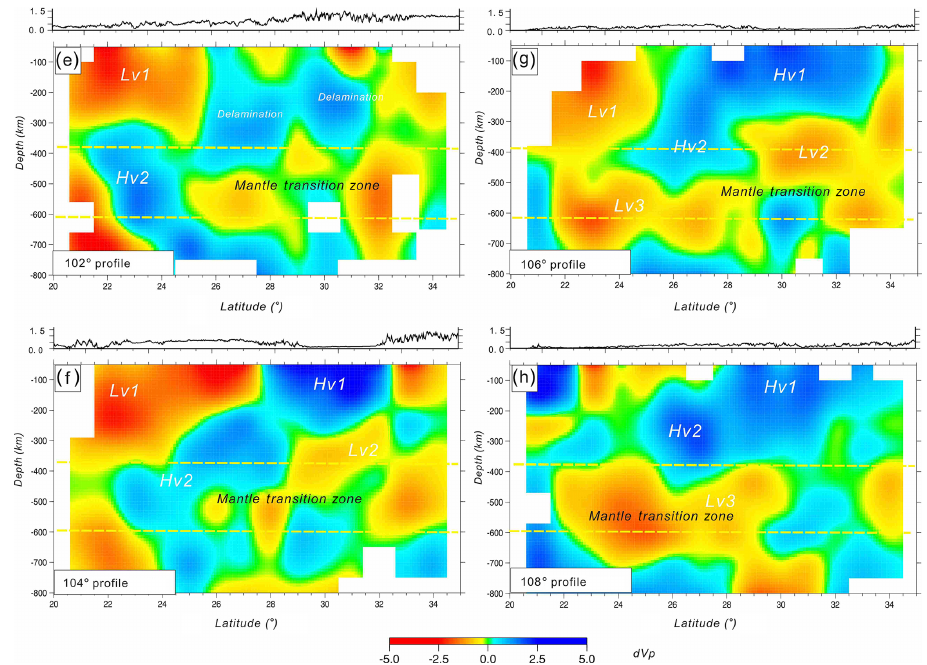
Figure 10. P-wave perturbation profiles along the north–south direction ( e , f , g , and h are sections along longitudes 102, 104, 106, and 108 ◦ E, respectively) (see Fig. 1 for profile location). Portions of the model where the recovery of the starting model in the CRT was below 20% are not shown (see Fig.